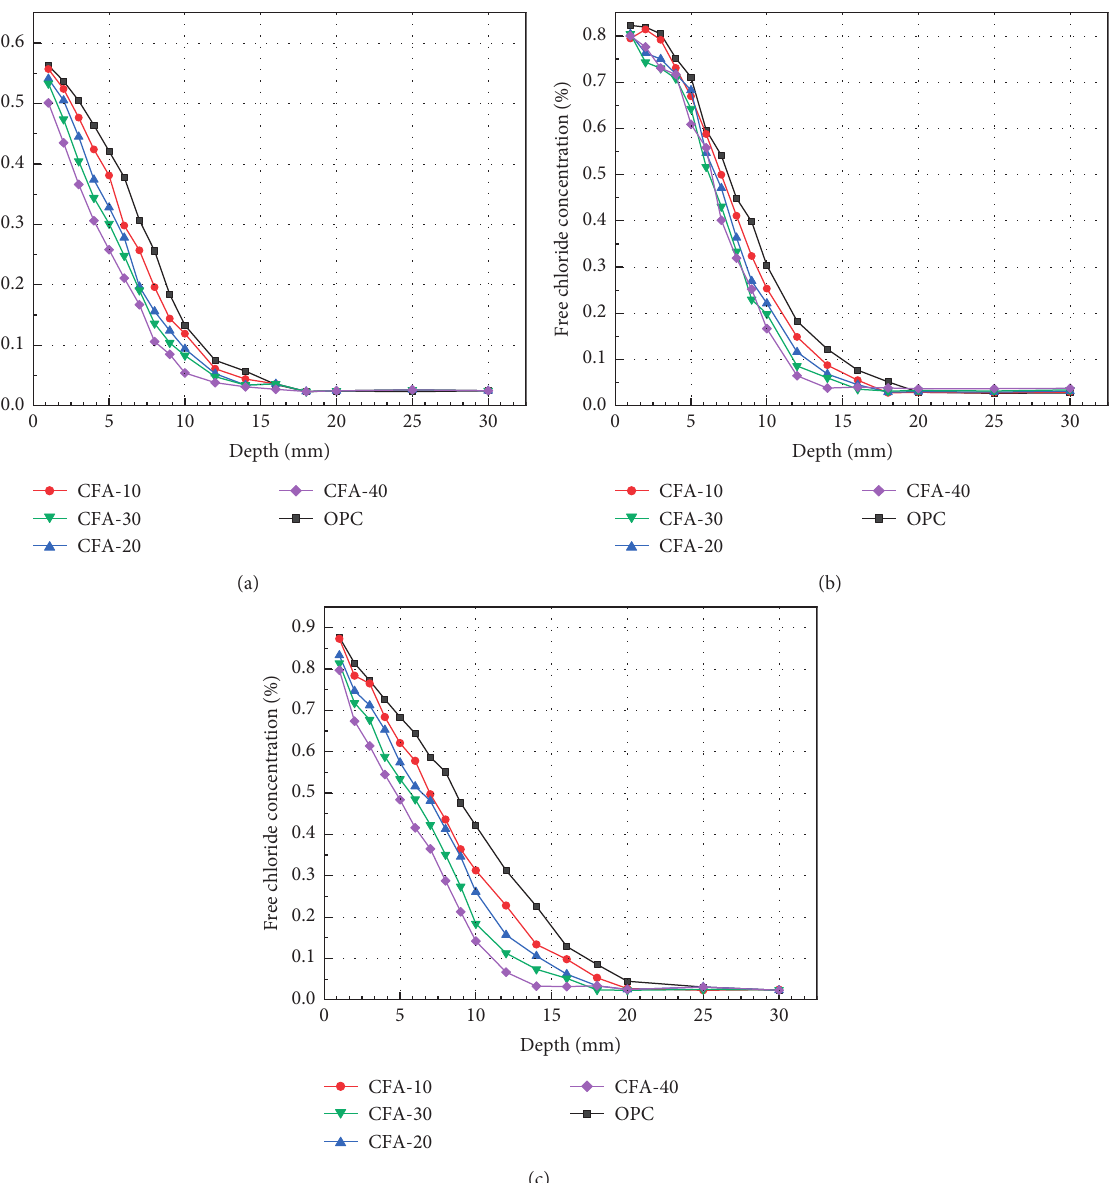
Figure 4: Variations in free chloride ion concentration with the depth of CFA. (a) NaCl-1.5%. (b) NaCl-3.5%. (c)